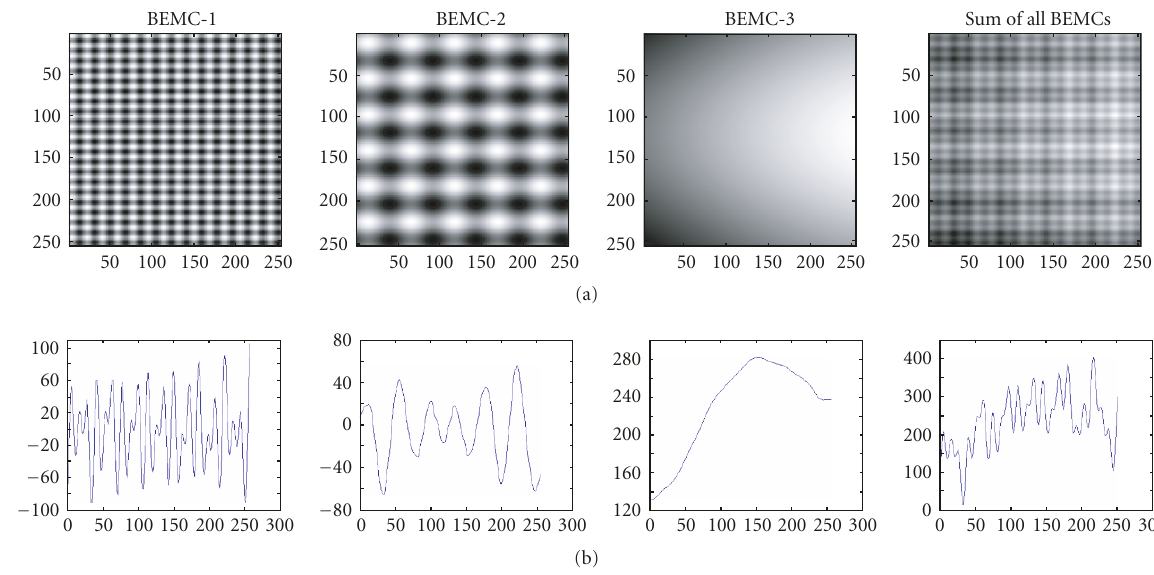
Figure 12: Decomposition of the STI using FABEMD with Type-4 OSFW (MNAI = 1) (a) BEMC-1 to BEMC-3 and summation of the BEMCs, (b) diagonal intensity profiles of BEMC-1 to BEMC-3 and summation of the BEMCs.